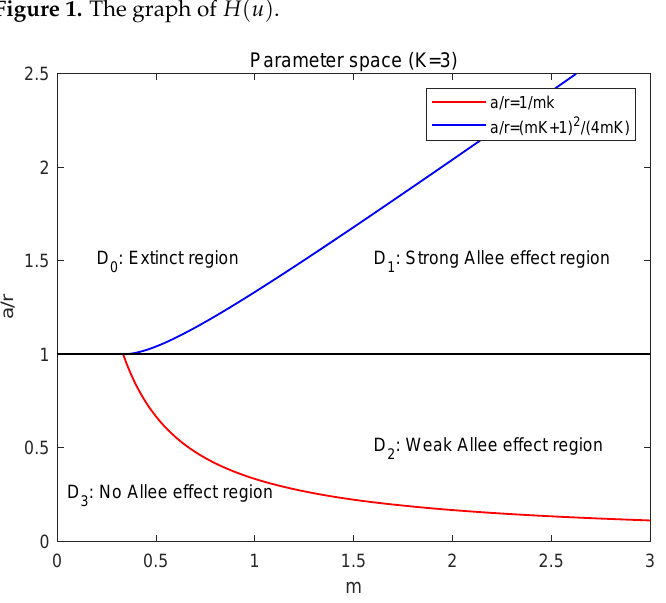
Figure 2. The parameter space D